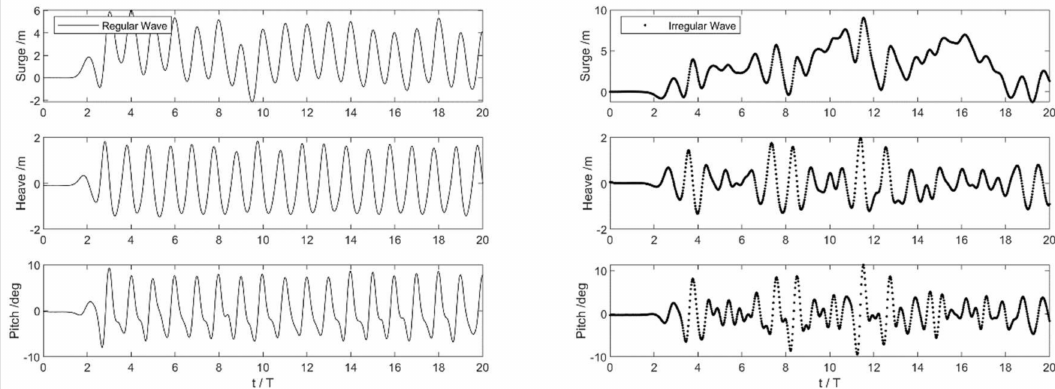
Figure 14. Time series of 3-DoF motions of the mariculture platform under the regular and irregular waves with H = 3.7 m, T = 9.9 s, and d = 11.88 m simulated with